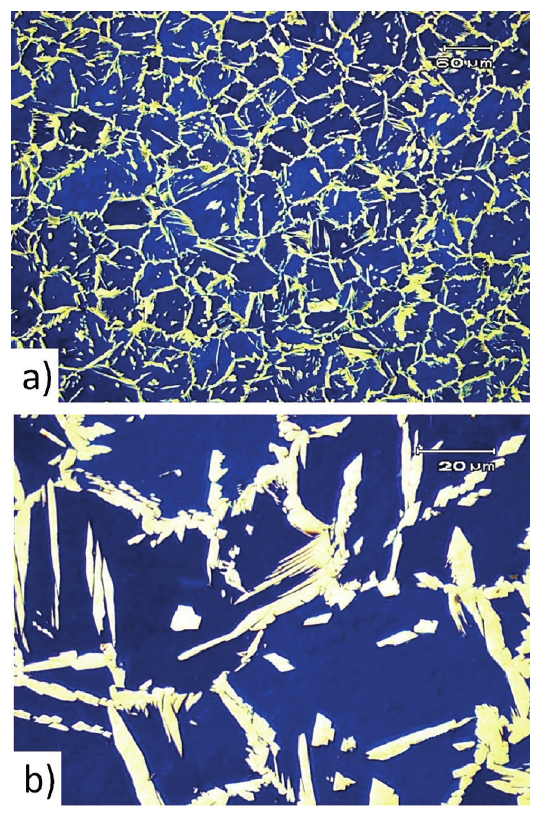
Figure 7: Schematic illustration showing the different zones observed. in MZ to satisfy the duplex criteria due to rapid